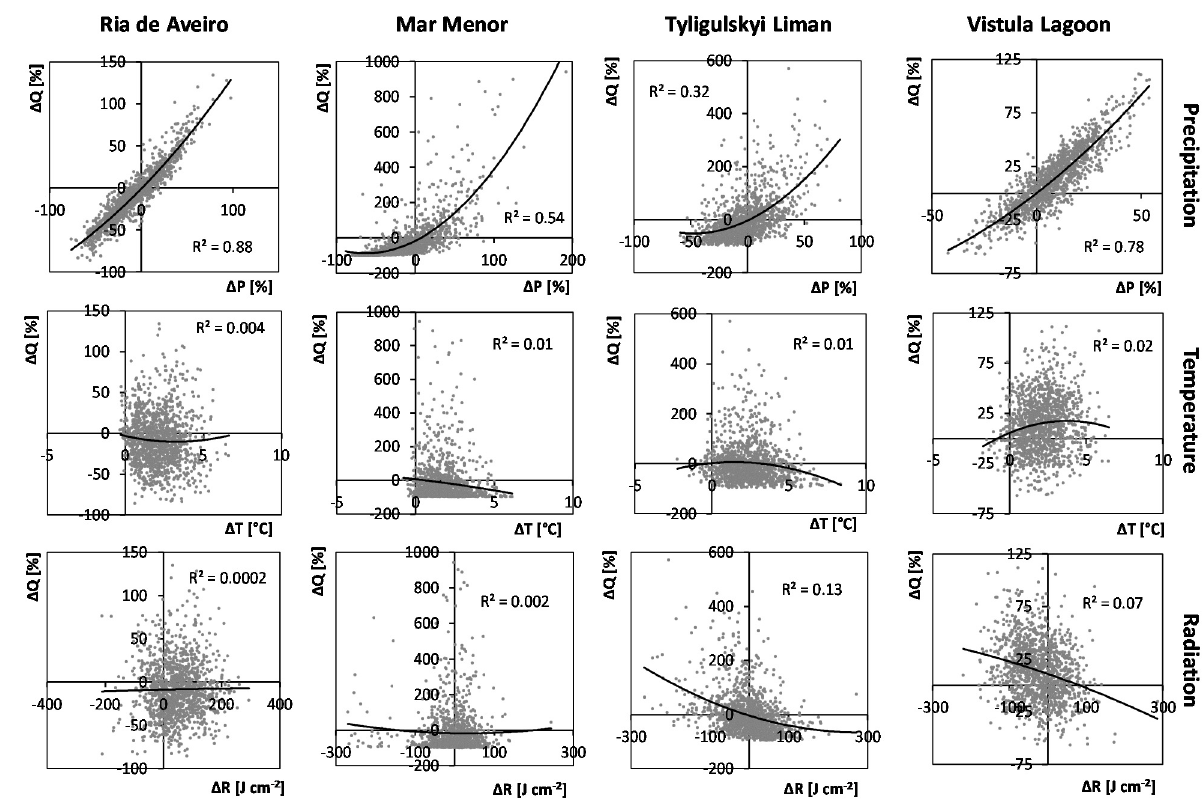
Figure 7. Climate sensitivity of the total freshwater inflow to the four lagoons for 15 ENSEMBLES climate scenarios: change of modelled annual discharge ( Δ Q ) per change of annual sum of precipitation ( Δ P ), average annual temperature ( Δ T ), and average annual solar radiation ( Δ R ) for the single years 2011–2098 compared to the mean of the reference period 1971–2000 for the same scenario.